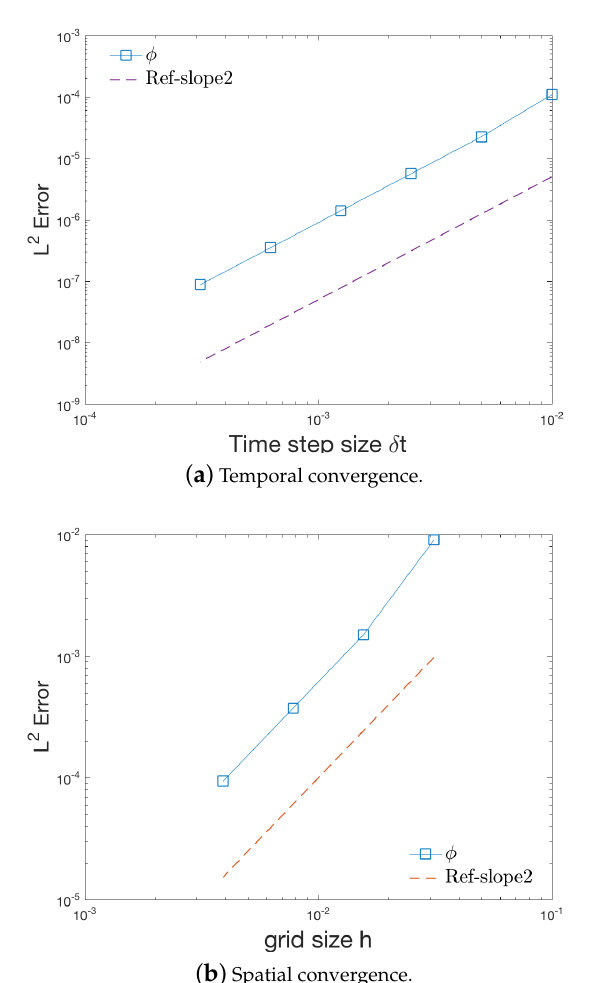
Figure 1. ( a ) Convergence test in time where the L 2 numerical errors for the phase field variable φ are computed by using various time step size δ t , and ( b ) convergence test in time where the L 2 numerical errors for the phase-field variable φ are computed by using various grid size h